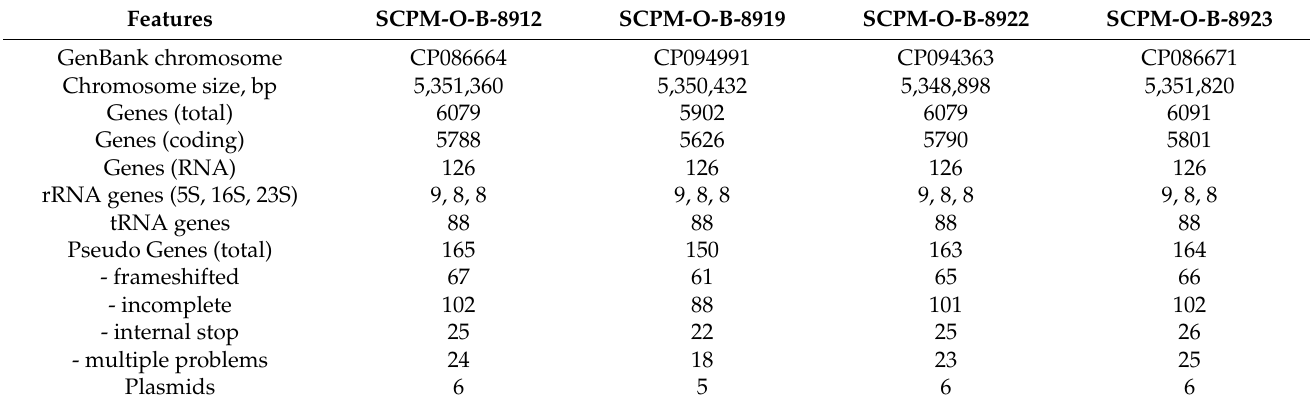
Table 3. Major genome characteristics of clinical K. pneumoniae